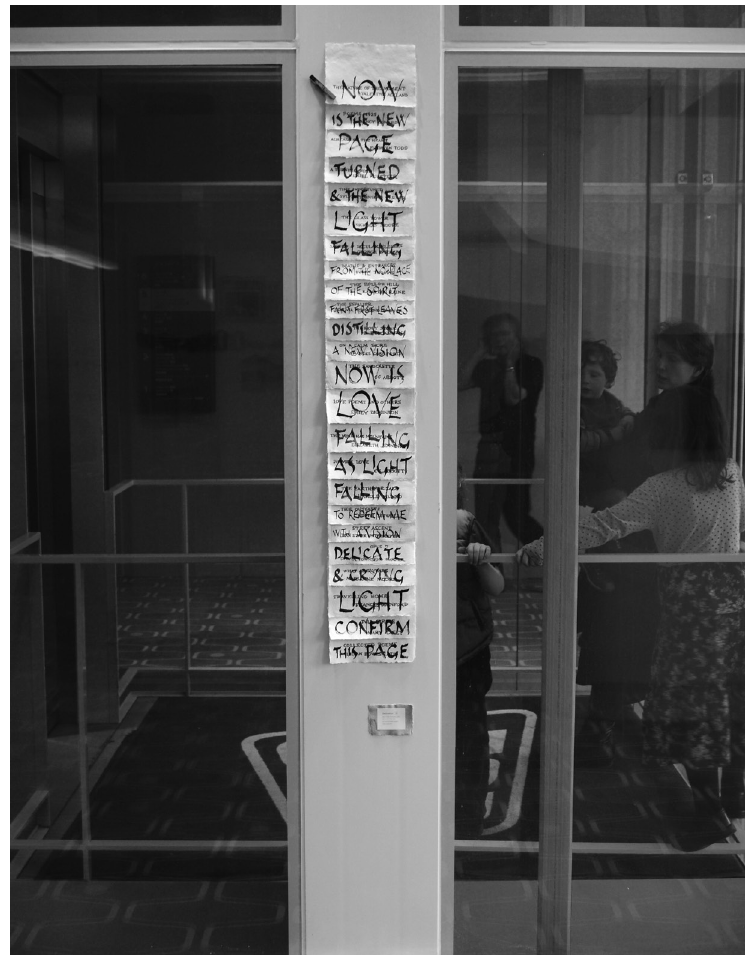
Figure 6 Dedication on display in the NPL. Photograph © 2020 Liz